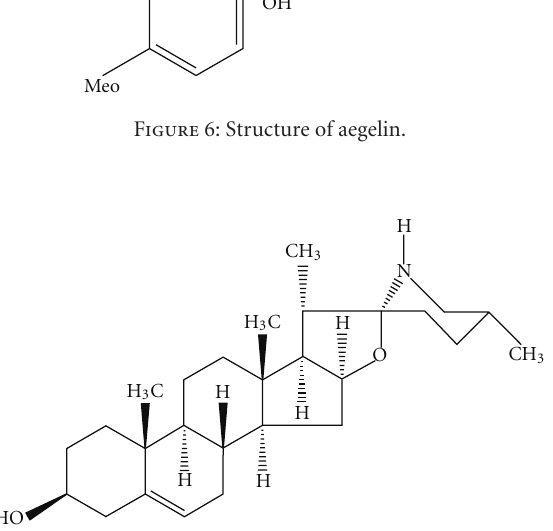
Figure 7: Structure of